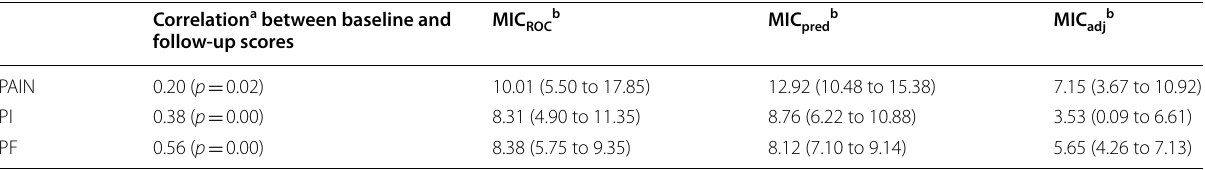
MIC ROC minimal important change determined with the receiver operating characteristic (ROC) curve; MIC pred predicted MIC; MIC adj adjusted predicted MIC; PAIN pain intensity; PI pain interference; PF physical function a Pearson correlation coefficient, r b Results are given as the mean MIC and 95% confidence interval after bootstrapping (n